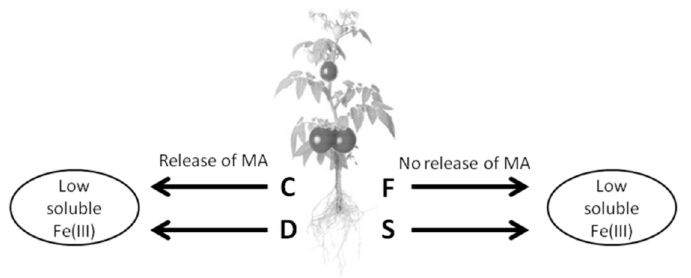
Figure 8. Scheme showing suggested Fe-solubilizing mechanisms occurring in rhizosphere when tomato plants were grown in complete nutrient solution (control, C) or under Fe (F), sulfur (S) and combined Fe + S deficiency (D).